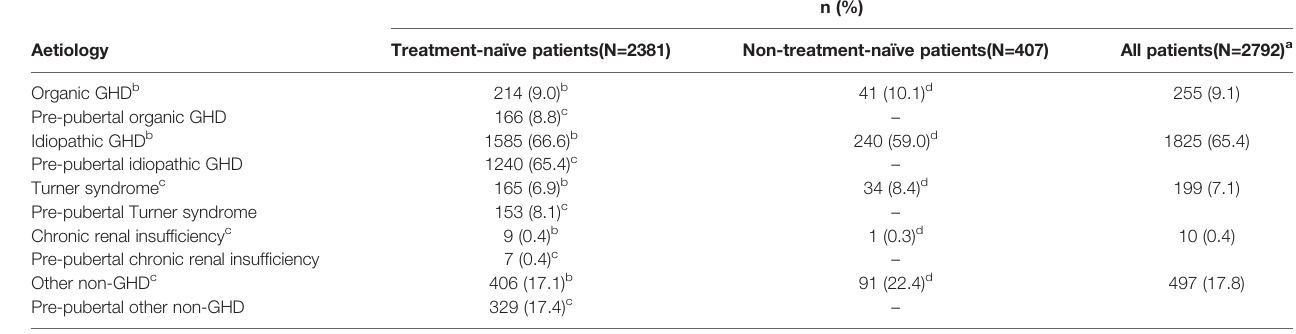
a Information on treatment-naive status missing for four patients. b Percentage of total treatment-naïve population. c Percentage of total treatment-naïve pre-pubertal population. d Percentage of total non-treatment-naïve population.